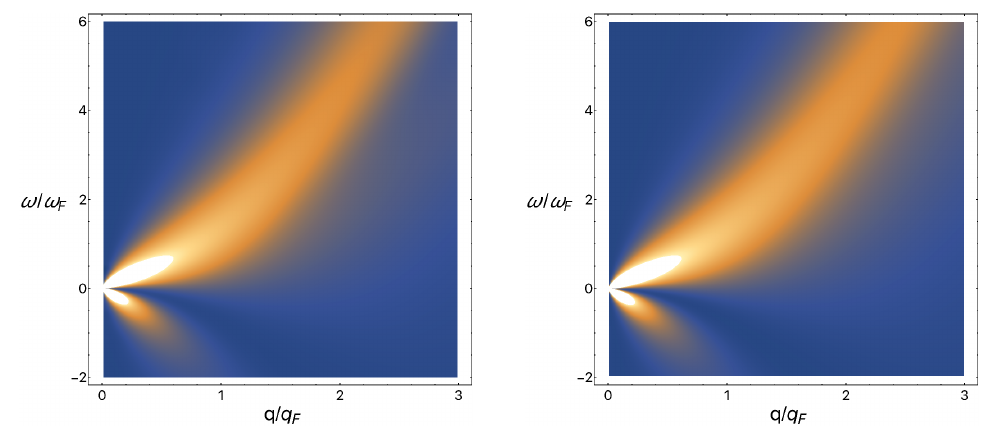
Figure 8: S ( q , ω ) (left panel) and one particle-hole contribution S ( 1 ) ( q , ω ) (right panel) as functions of q , ω for the steady state root density (62) with c = 4 and D = 1 /π . The color scale is the same for both